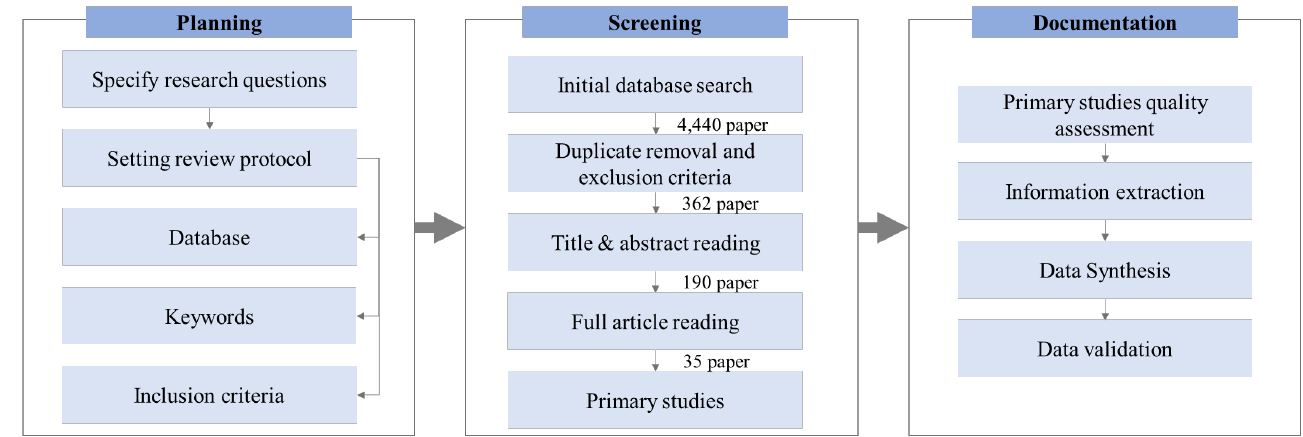
Figure 1. Framework of the review phase execution.